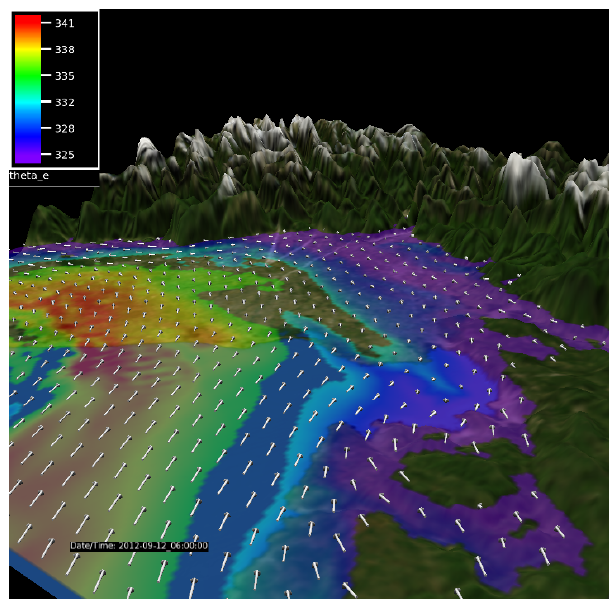
Figure 4. Wind vectors at 350m height (white arrows) and θ e at 300m (shaded) at 06:00UTC, 12 September 2012 (IOP 2), from a Weather Research and Forecasting (WRF) model run initialized with the Global Forecasting System (GFS) analysis at 12:00UTC, 11 September. Fields are shown in the innermost parts (1km grid spacing) of the three domains used (from Miglietta et al.,